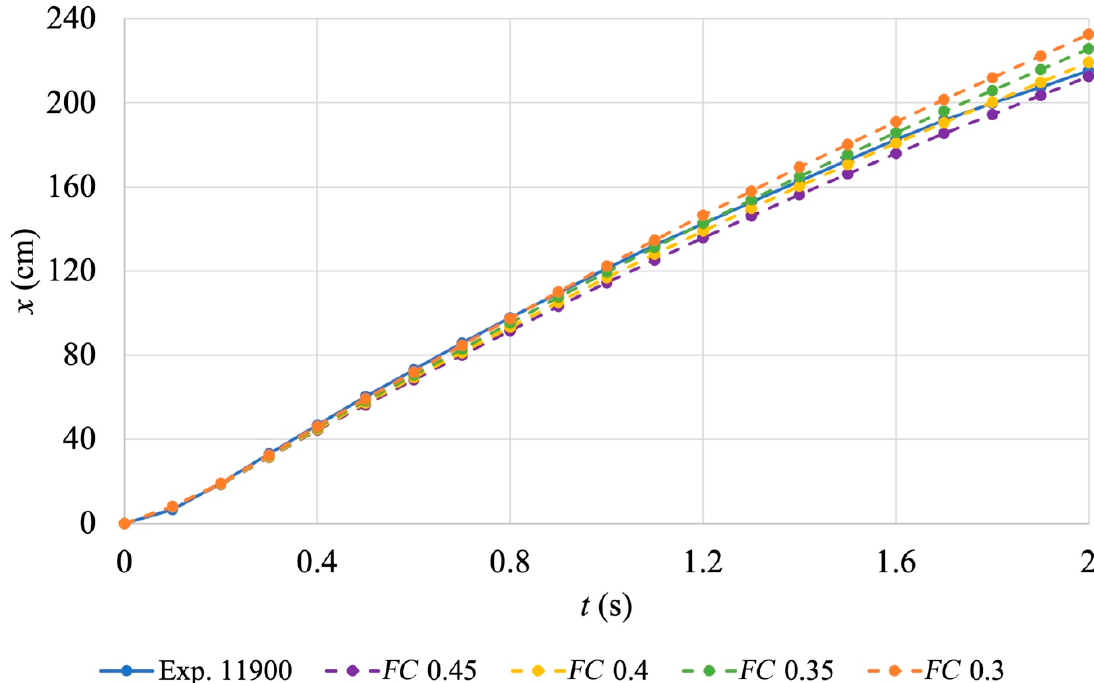
Figure 9. Comparison between the output value ( x -directional center-of-gravity displacement position of the FS3M numerical simulation) and the center-of-gravity displacement position of the container in the x direction obtained from Tomita et al. [18] (hydraulic experimental Configuration 11900). Here, t refers to the time matched at the beginning of the container.